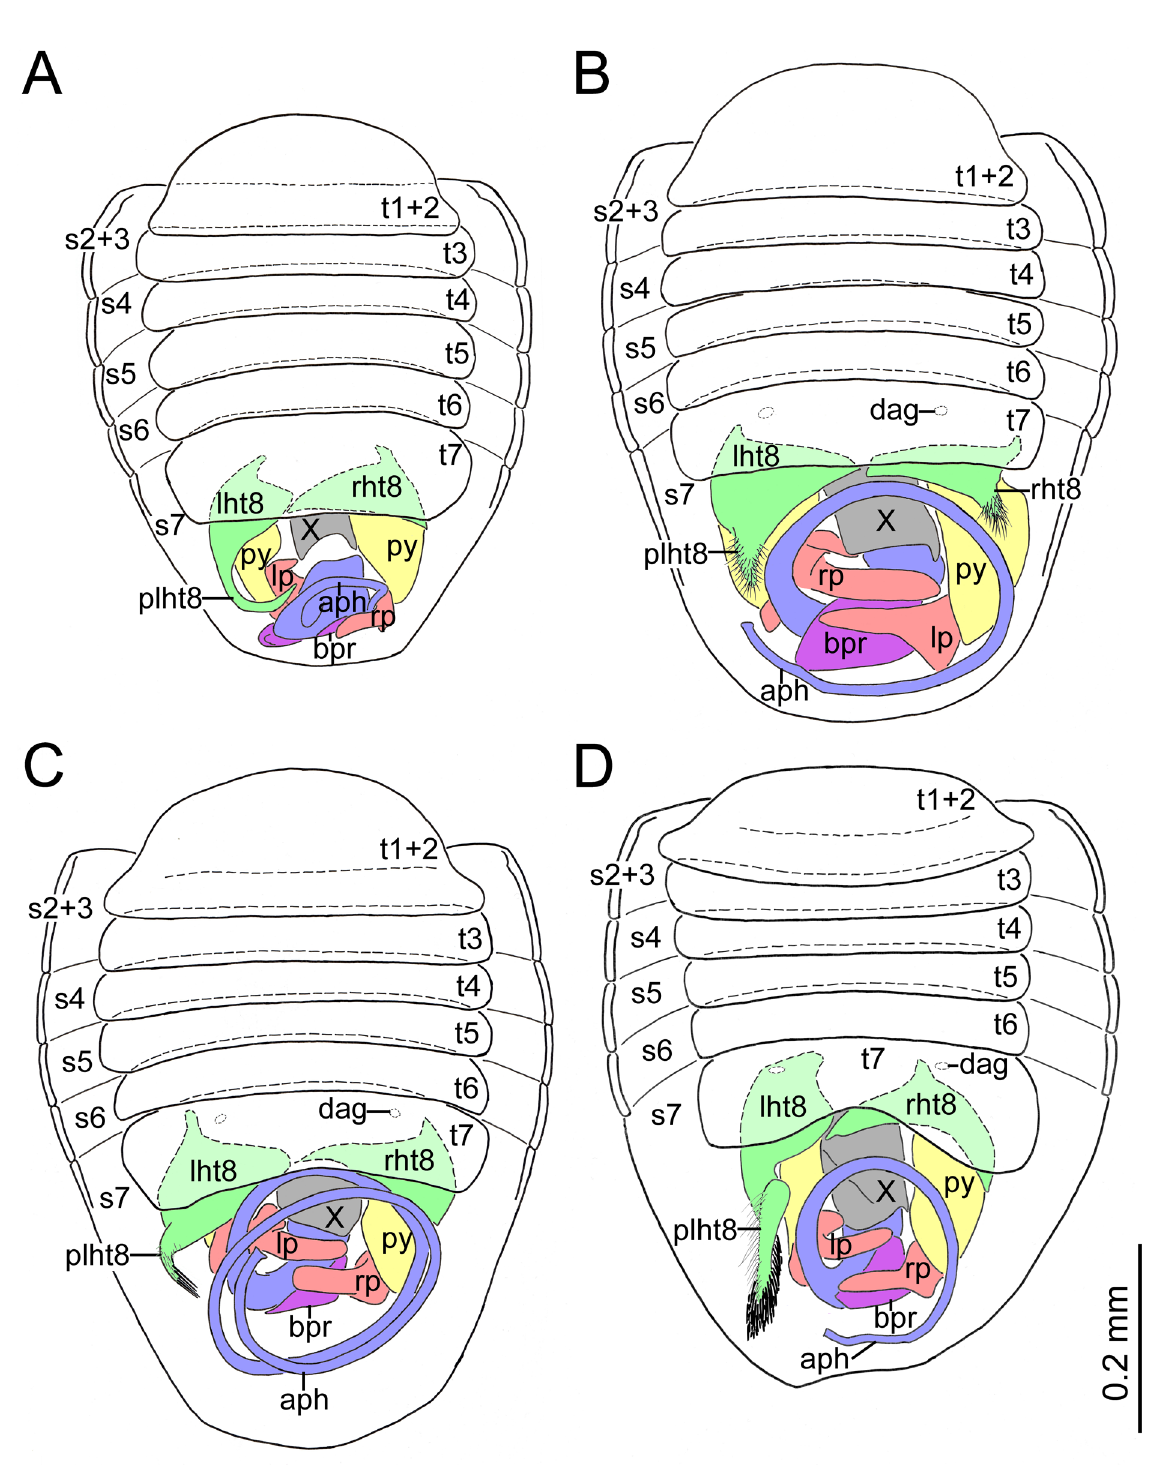
Fig. 30. Pregenital abdomen and genitalia of Kokeshia spp., dorsal views. A . K. redeii sp. nov., paratype, ♂ (SYSBM). B . K. renae sp. nov., paratype, ♂ (SYSBM). C . K. weirauchae sp. nov., paratype, ♂ (SYSBM). D . K. xiei Rédei, Ren & Bu, 2012, ♂ (SYSBM). Abbreviations: see Material and